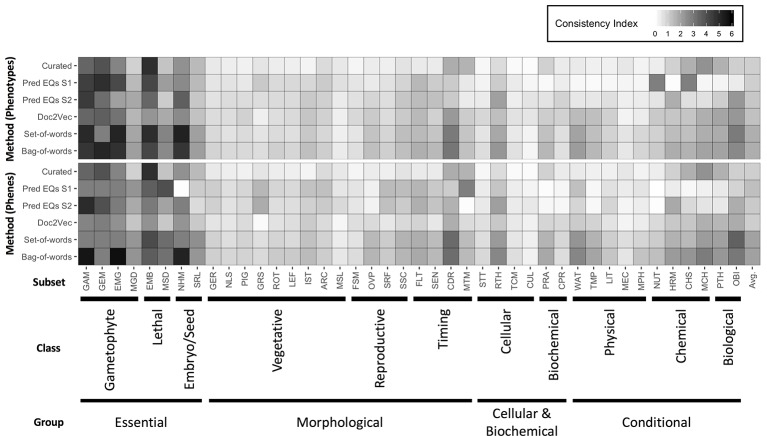
Heatmap of Consistency Index. The difference between average similarity for two phenotypes within a subset and one phenotype within and one outside, for each functional subset defined in the dataset of Arabidopsis phenotypes, and for each method of quantifying similarity between phenotypes is shown, with darker cells indicating higher consistency within a subset. Differences are measured in standard deviations of the distributions of similarities obtained for each method. The meaning of subset abbreviations are specified in
Supplemental Table 1
 of Lloyd and Meinke (2012). Methods are listed at left. Input text for calculating similarities between the phenotypes were either derived from phenotype descriptions (top) or phene descriptions (bottom). The far right column in the heatmap refers to an average Consistency Index for a given method across all subsets.